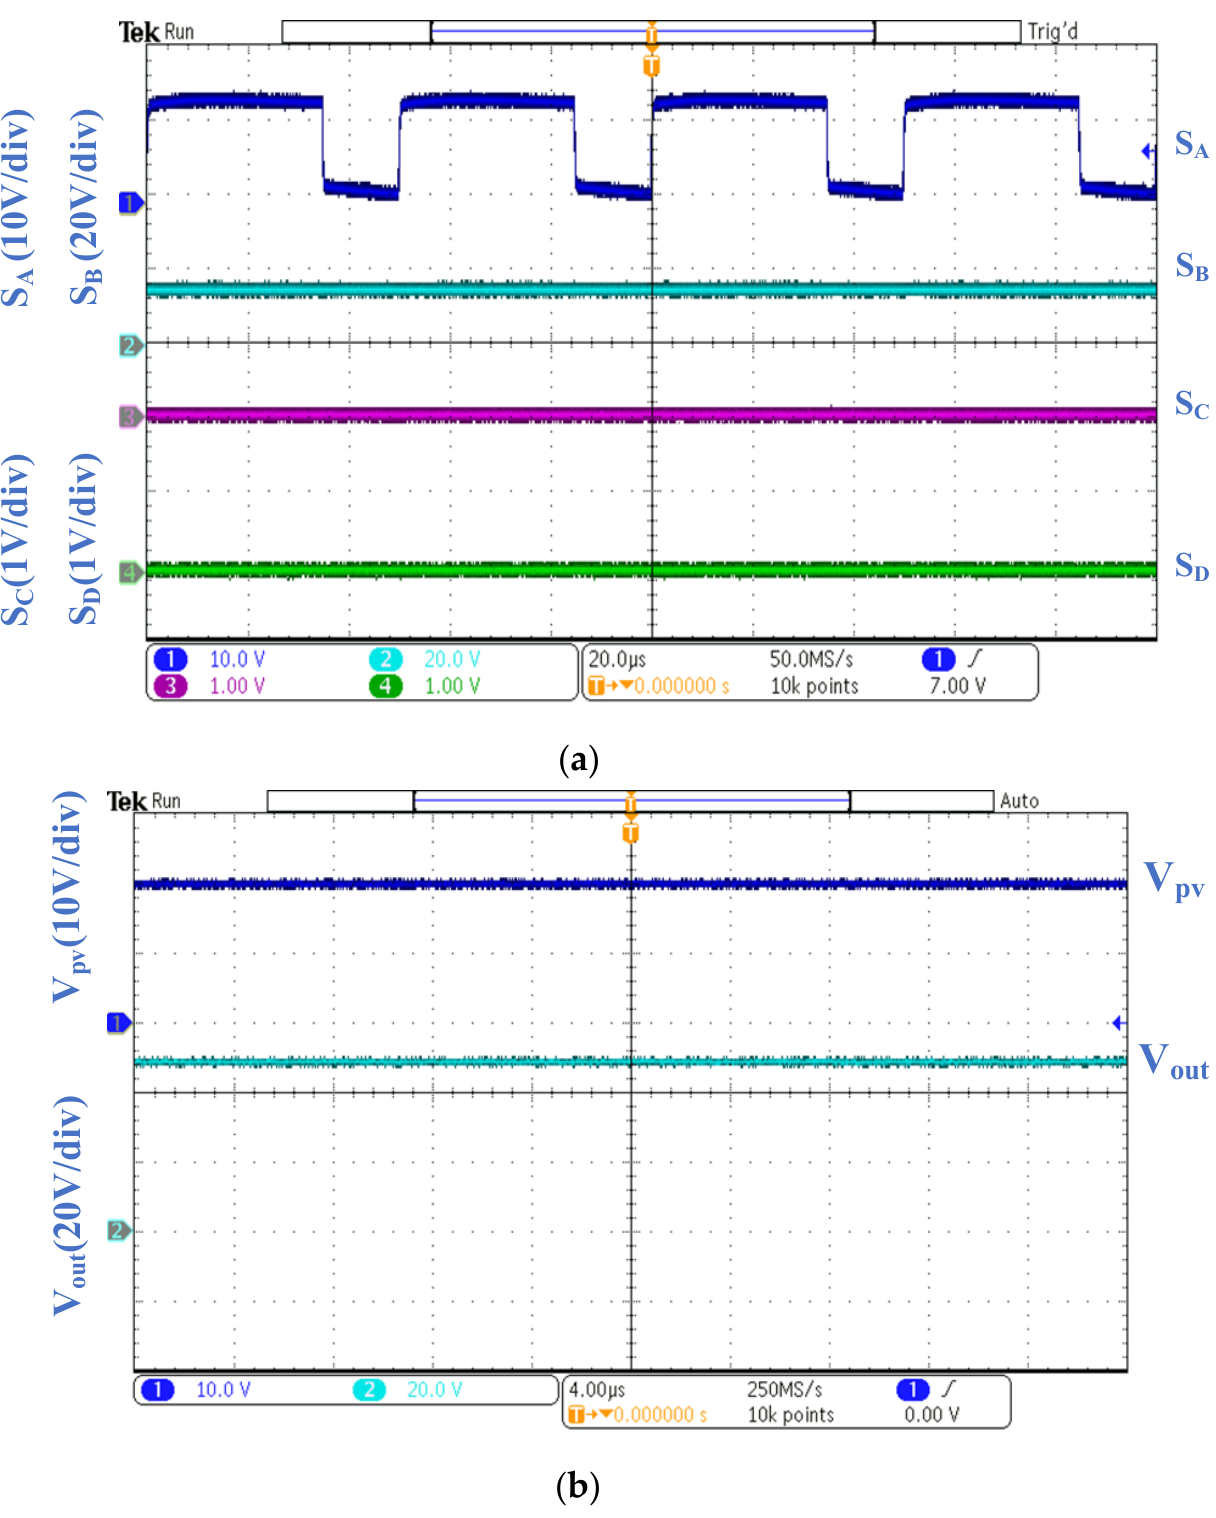
Figure 10. Experimental waveforms of the proposed IIABB converter for V pv of 20 V and N = 1: ( a ) experimental waveforms of switches S A and S B are operating; S C and S D are not operating; and ( b ) waveforms of V pv = 20 V and output voltage V out = 48 V via an intelligent control strategy at a duty cycle of 0.7.